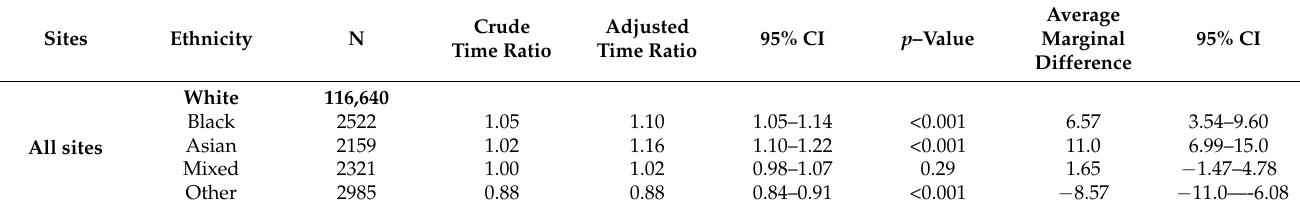
Table 3. Association between ethnicity and diagnostic interval by cancer